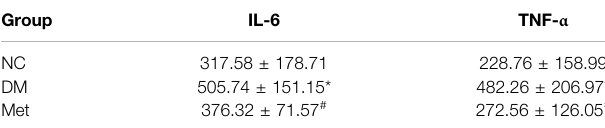
TABLE 2 | Content of IL-6 and TNF- α in the renal tissue supernatant of mice in each group (n = 6,* p < 0.05 vs. NC. # p < 0.05 vs. DM). Group